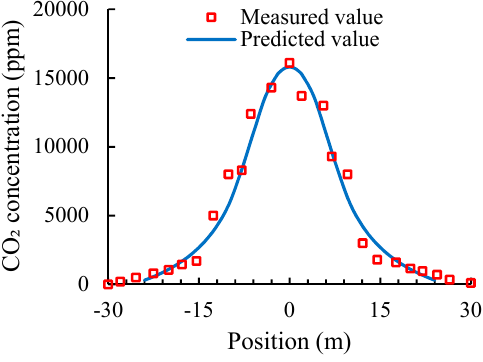
Figure 11. Comparison of CO 2 concentrations measured in situ and in the numerical simulation.